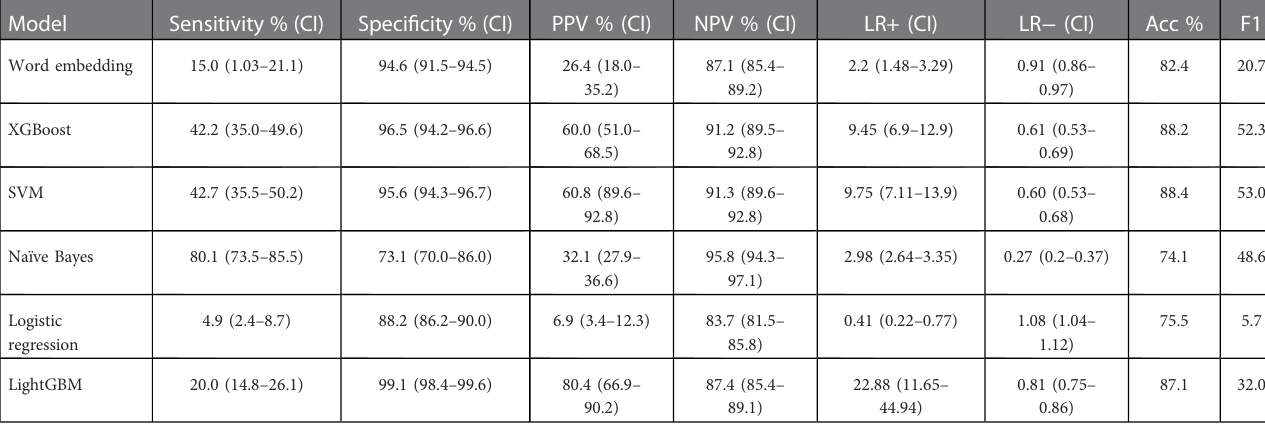
TABLE 5 Model characteristics of the validation cohort when using an outcome based on any ICD-9 diagnosis code of pneumonia.